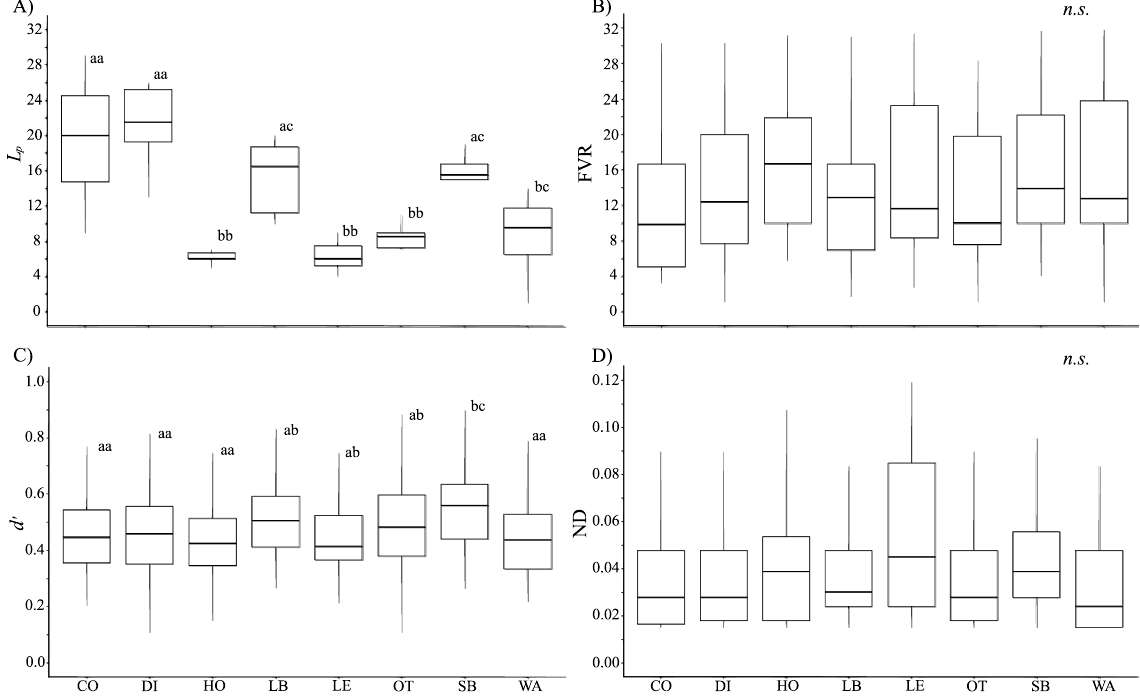
Figure 3. Variation across pollinator functional groups (in alphabetical order) of the four response variables considered in this study. Boxplots indicating the median, the 25th and 75th percentiles and the data range (vertical bar): A) Pollinator species richness per plant species ( L p ), B) Flower visitation rate (FVR), C) Complementary specialisation index ( d’ ), and D) normalised pollinator degree. Functional groups are Coleopterans (CO), Dipterans (DI), Hoverflies (HO), Large bees (LB), Lepidoptera (LE), Others (OT), Small bees (SB) and Wasps (WA). Data from 2009 and 2010 were pooled. The bars that share letters are not significantly different from each